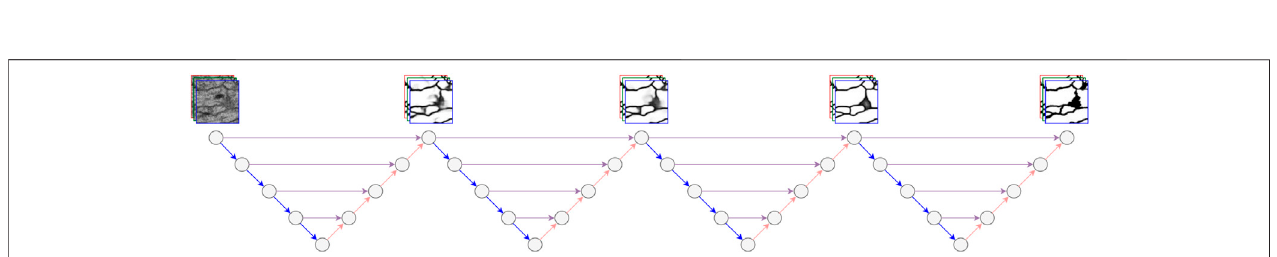
FIGURE 6 | FusionNetW 4 , a chain of four concatenated FusionNet units.